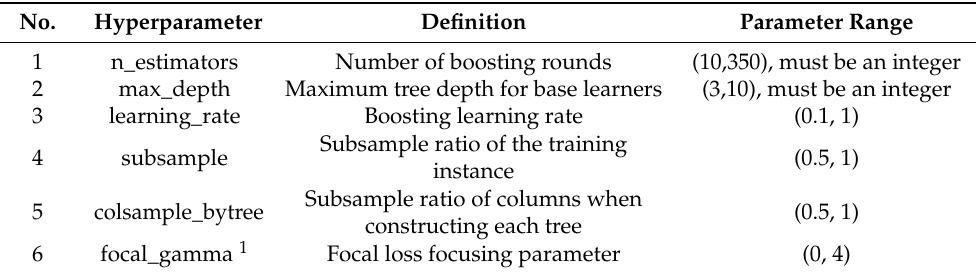
Table 1. Hyperparameters to